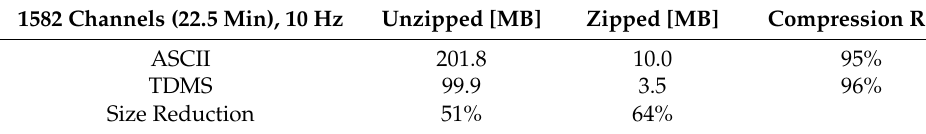
Figure 7. ASCII vs. TDMS Memory Usage Comparison. Table 1. ASCII vs. TDMS Compression Ratio